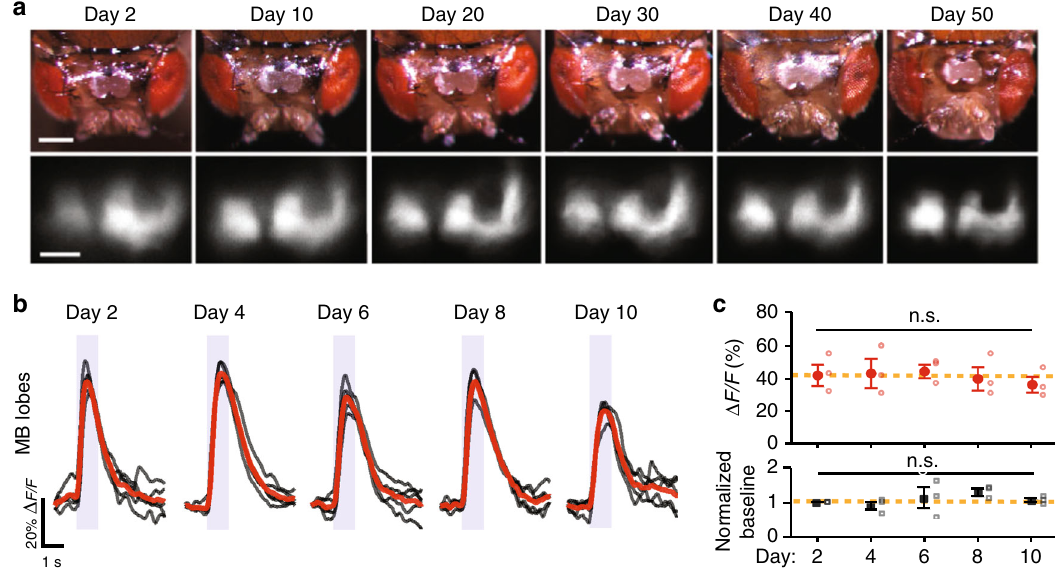
Fig. 5 Long-term in vivo imaging of neural Ca 2+ activity. a Example images of the surgically created imaging window (upper panels) and fl uorescent mushroom bodies expressing the Ca 2+ indicator GCaMP6f in OK107-GAL4 > 20 × UAS-GCaMP6f fl ies (lower panels). The imaging window was transparent across the 50-day interval, and GCaMP6f expression appeared stable across this period. Scale bars are 200 µ m (upper panels) and 100 µ m (lower panels). b Example traces of odor-evoked neural Ca 2+ activity in the mushroom body of an OK107-GAL4 > 20 × UAS-GCaMP6f fl y. Gray traces: individual trials ( n = 5). Red traces: mean responses. Shaded intervals: periods of olfactory stimulation (1 s duration) with 2% ethyl acetate. c Peak amplitudes of odor-evoked Ca 2+ activity (upper) and normalized levels of baseline fl uorescence (lower) in the mushroom body were both stable for 10 days ( P = 0.4 and 0.3 for upper and lower panels, respectively; Friedman ANOVA; n = 3 female OK107-GAL4 > 20 × UAS-GCaMP6f fl ies). Closed data points denote mean values, and open data points mark values for individual fl ies. We normalized the baseline fl uorescence levels in each fl y to their values on Day 2. Error bars are s.e.m. Yellow dashed lines denote mean values averaged over all 10